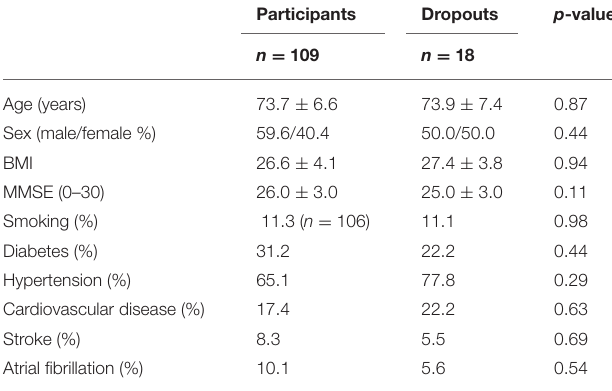
TABLE 1 | Characteristics of included participants and dropouts at